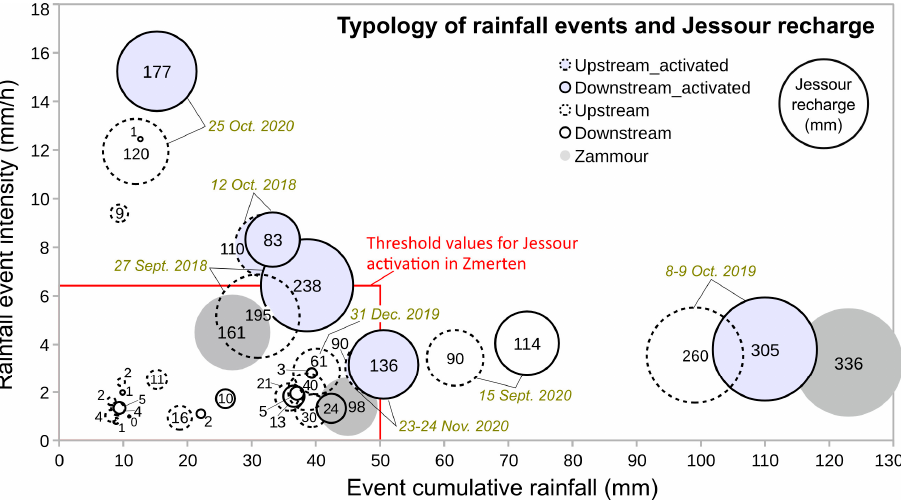
Figure 11. Typology of rainfall events (maximum hourly intensity, event cumulative rainfall), activation and soil moisture recharge for the upstream and downstream Jessour. The values in grey are for the site of Zammour, investigated with the same approach in a previous study [11].